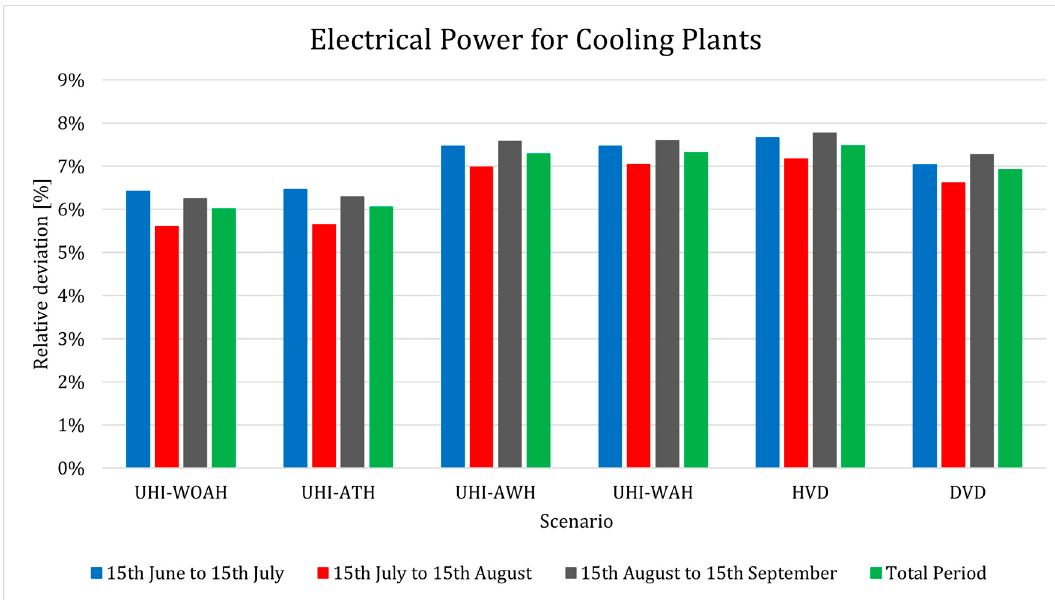
Figure 10. Relative deviation of the district electrical energy demand for different scenarios with respect to the case without considering the urban heat island effect.